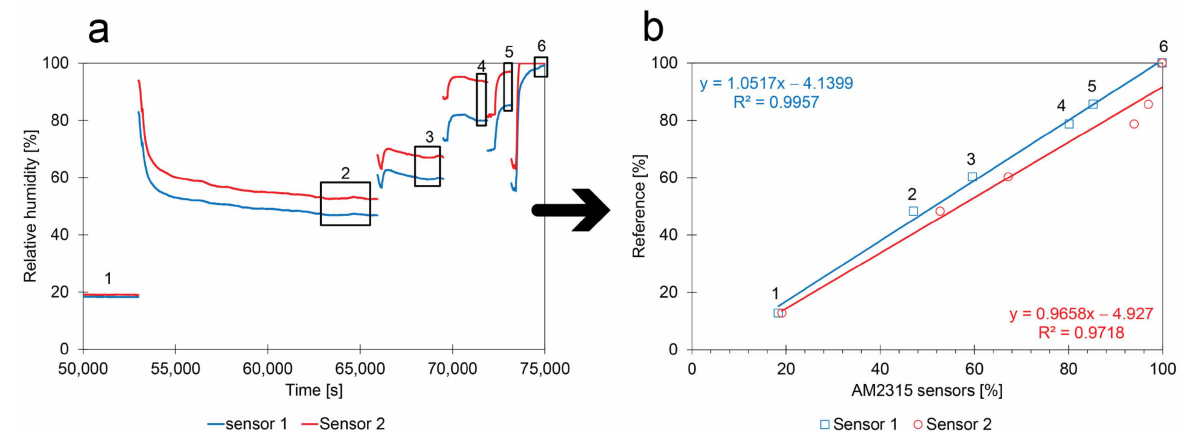
Figure 10. Calibration curves obtained for RH using aqueous glycerol solutions and performed in Cuba (tropical climate); ( a ) the raw data of the different experiments were concatenated into a single time series but the trend of experiment 1 is not entirely shown; ( b ) calibration curve obtained from the experiments.